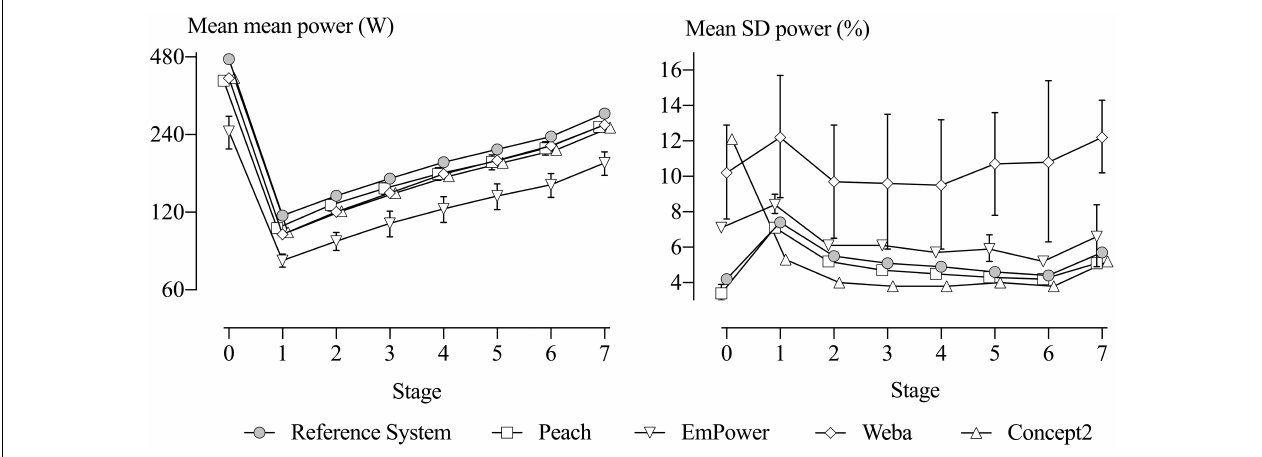
FIGURE 7 | Means of the mean (left) and SD (right) of power for each device in each stage for all the testing sessions. SD bars represent between-unit SD for the means and SD. The Reference System and the Concept2 have no SD bars, as only one unit was tested. SD bars on the right are omitted from some stages for Peach and EmPower, reflecting negative variance. Stage 0 represents the 30-s maximal